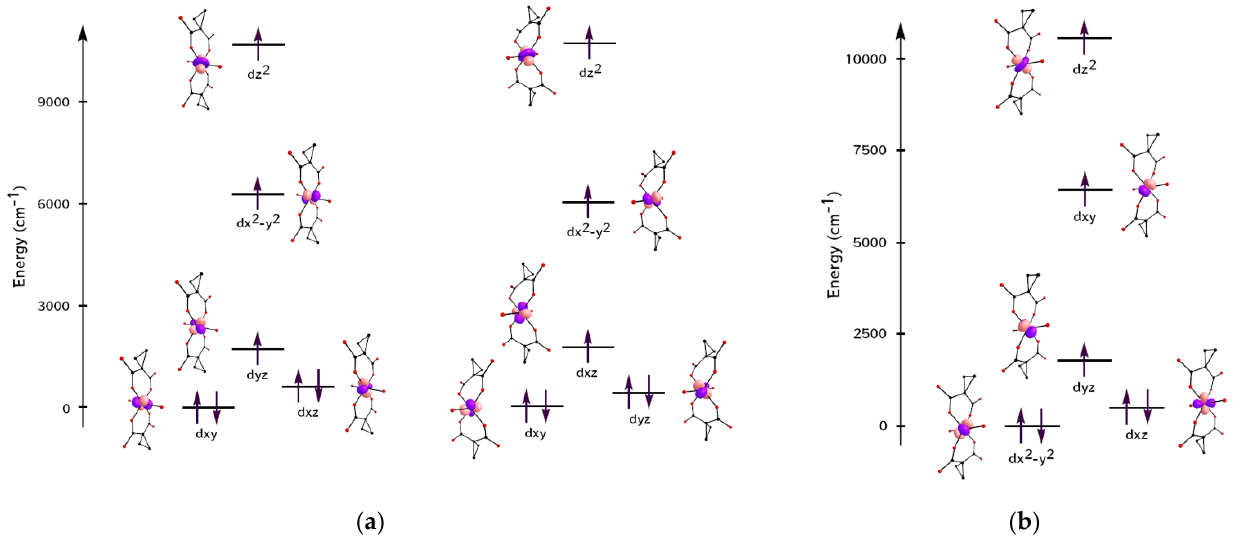
Figure 4. ( a ) Co 2+ ion d-AO splitting in {Co1(cpdc) 2 (H 2 O)} 2- (left) and {Co2(cpdc) 2 (H 2 O)} 2- (right) anions in complex 1; (b) Co 2+ ion d-AO splitting in [Co1(cpdc) 2 (H 2 O)] 2- anion in complex 2.